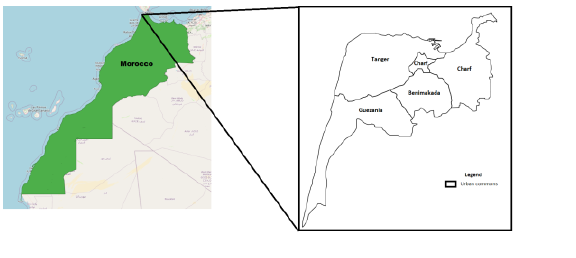
Figure 1 . Tangier city localization